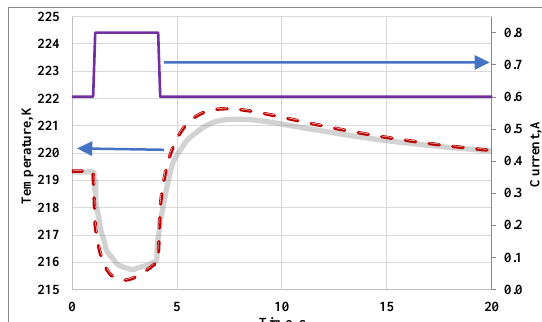
Figure 16. Transient calculation of Peltier-supercooling. A short current pulse (upper magenta line) generates temporarily lower cold side temperatures. The gray solid line demonstrates results of the finite element simulation from [33], the dashed line corresponds to a simulation by the proposed method.